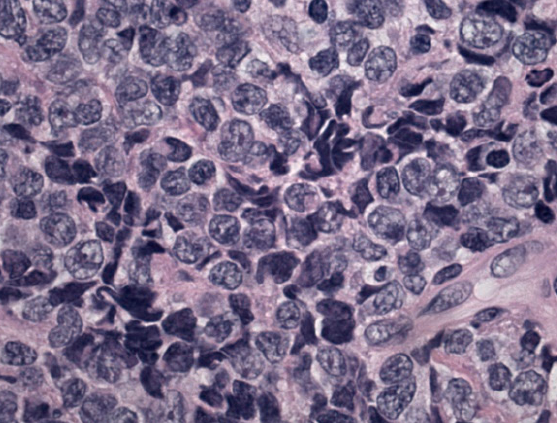
Figure 2. Morphological details investigated using hematoxylin and eosin staining: monomorphic population of blasts.